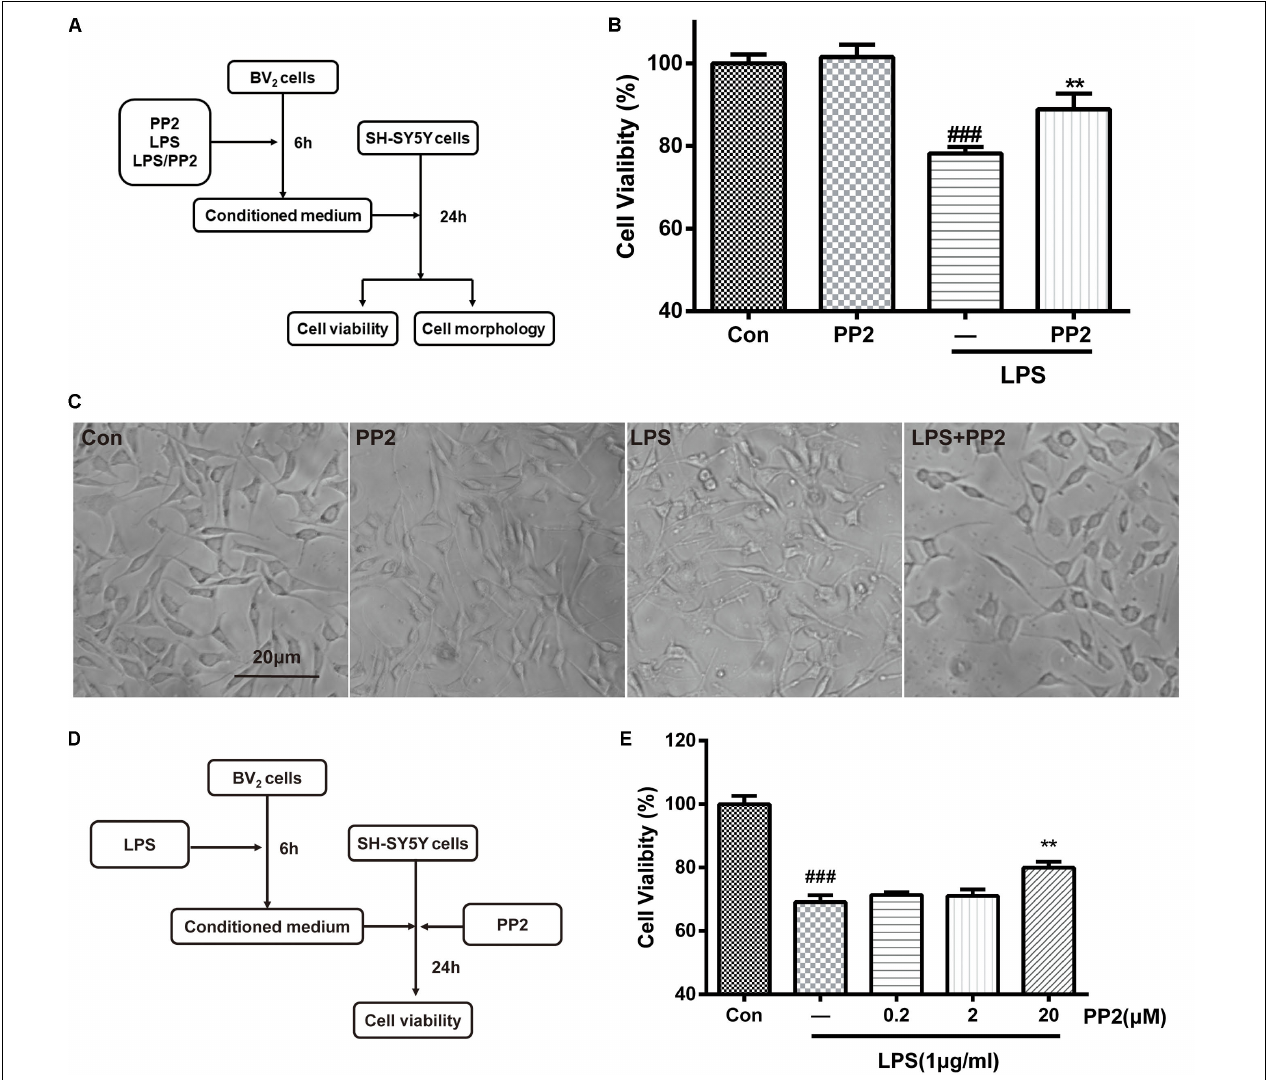
FIGURE 3 | Src inhibition decreased neurotoxicity mediated by lipopolysaccharide (LPS)-stimulated microglia. (A) The experimental design. (B) The cell viability of SH-SY5Y cells was assessed by MTT assay. Each bar represents the mean ± SEM. n = 6. ## P < 0.01 vs. control group, ** P < 0.01 vs. LPS group. (C) The morphology of SH-SY5Y cells was observed by the phase-contrast microscope (scale bar: 20 µ m). (D) The experimental design. (E) The cell viability of SH-SY5Y cells was assessed by MTT assay. Each bar represents the mean ± SEM. n = 5. ## P < 0.01 vs. control group, ** P < 0.01 vs. LPS